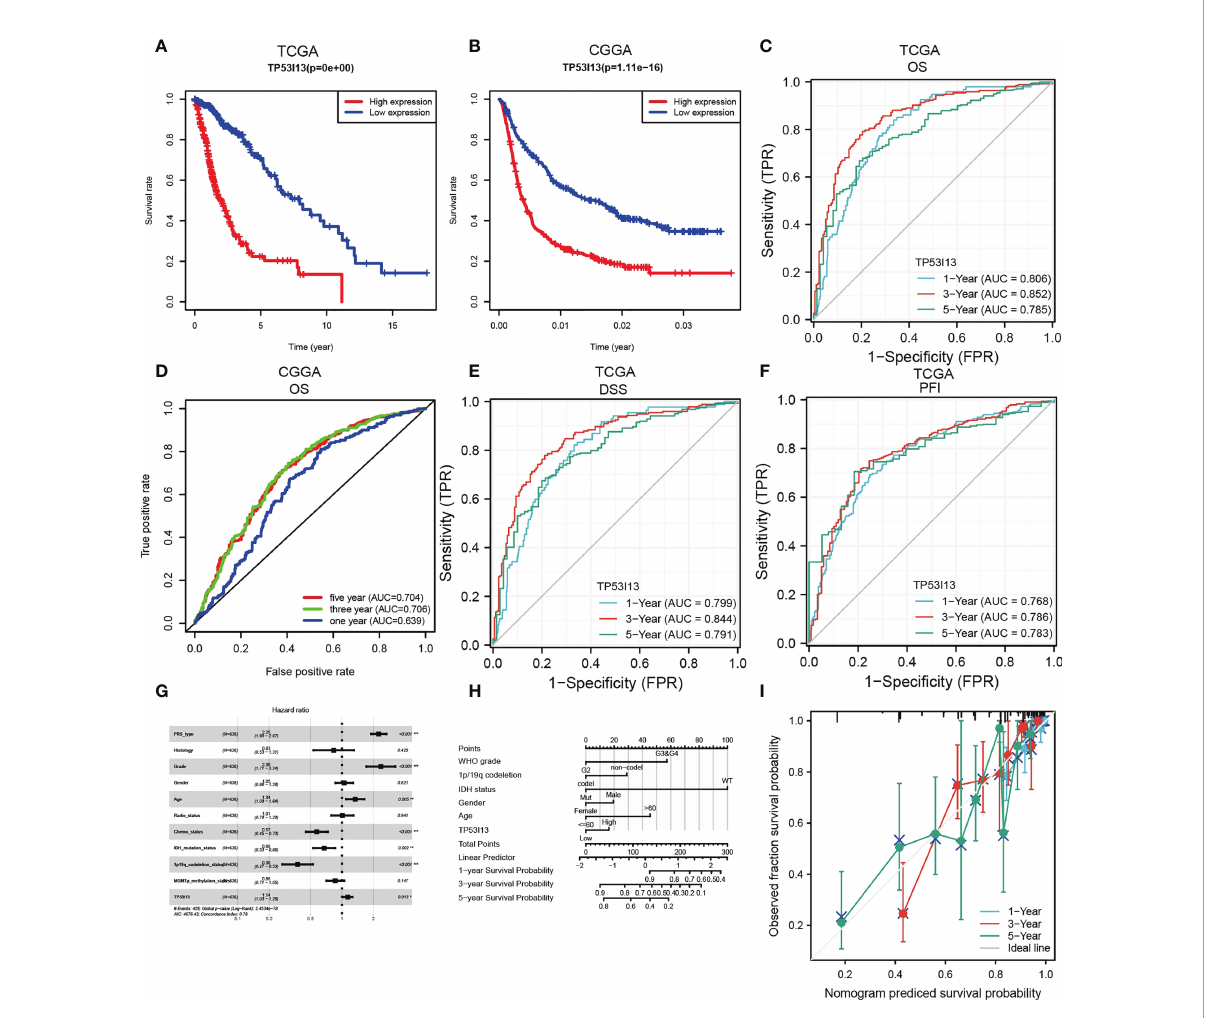
FIGURE 3 (A) Kaplan – Meier curve for overall survival (OS) of glioma patients with the TP53I13expression based on the TCGA database. (B) Kaplan – Meier curve of the OS of glioma patients with TP53I13 expression level based on the CGGA database. ROC curves for 1-, 3-, and 5-year OS analysis based on TP53I13 expression levels in glioma patient samples obtained from (C) TCGA (D) CGGA databases. (E) ROC curves for 1-, 3-, and 5- year DSS analysis of TP53I13 expression in glioma patient samples obtained from TCGA. (F) ROC curves for 1-, 3-, and 5-year PFI analysis of TP53I13 expression glioma patient samples obtained from TCGA. (G) Multivariate Cox regression analysis of the TP53I13 expression and clinical characteristics. (H) Nomogram for OS integrating TP53I13 expression level, WHO grade, 1p/19q codeletion status, IDH mutation status, sex, and age. (I) The calibration curve for predicting 1-, 3-, and 5-year OS in glioma